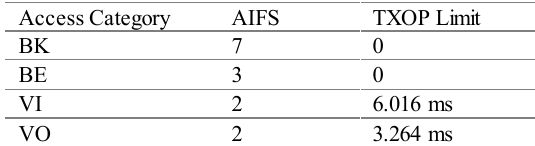
Table 1. The TXOP limit in